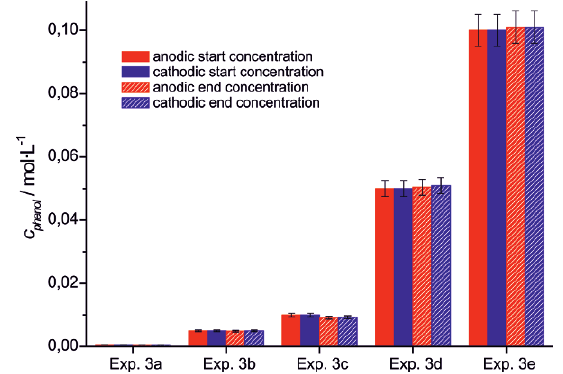
Figure 14. Concentration comparison after the equilibria experiments (3a-3e). The bridges were run for 600 s except Exp. 3c which was run for 580